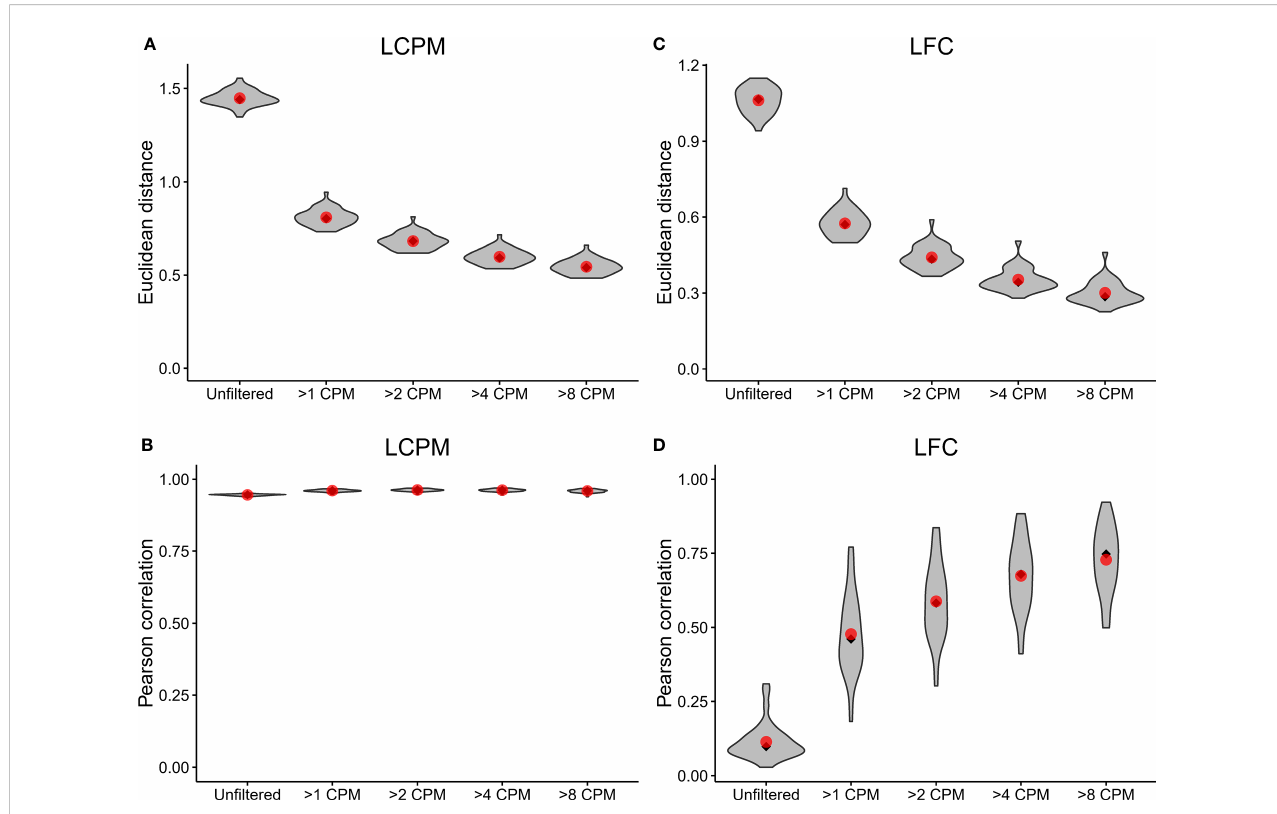
FIGURE 2 Inter-site agreement of RNA-Seq log 2 counts per million and fold-change estimates improves after fi ltering out lowly-expressed genes. LCPM: log 2 counts per million. LFC: log 2 fold change. (A) Violin plot depicting the distribution of adjusted Euclidean distance between Site 1 and Site 2 of the LCPM gene expression pro fi le for each subject. Each distribution consists of a total of 49 observations. Red dots mark the mean of the distribution, and black diamonds mark the median. Each column shows the distribution after fi ltering genes at the CPM thresholds indicated on the x-axis. (B) The same analysis and plotting design as described in (A) , but for the Pearson correlation between Site 1 and Site 2 of the LCPM gene expression pro fi le for each subject. (C, D) show the same results but calculated on the LFCs. For these, each distribution consists of a total of 36